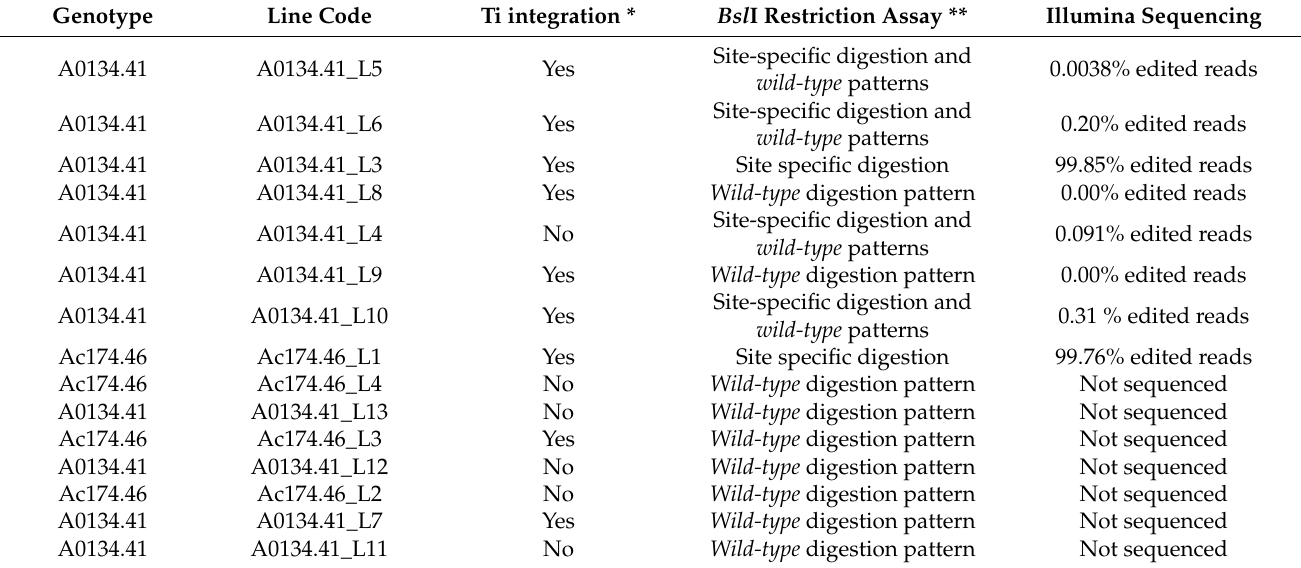
Table 2. Summary of the genetic evaluation for the putative transgenic regenerated line.